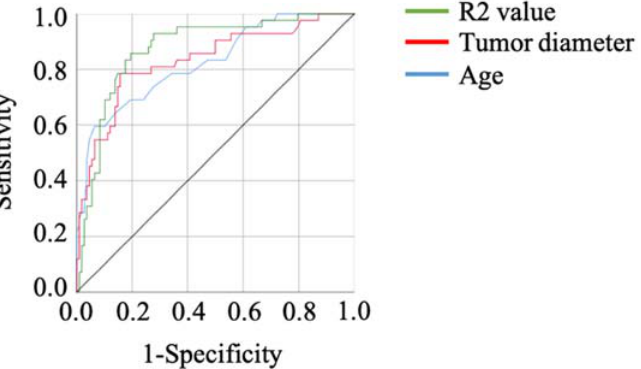
Figure 1. The ROC curves of the factors showing the top three specificities in the current cohort. The R2 value showed a high AUC.